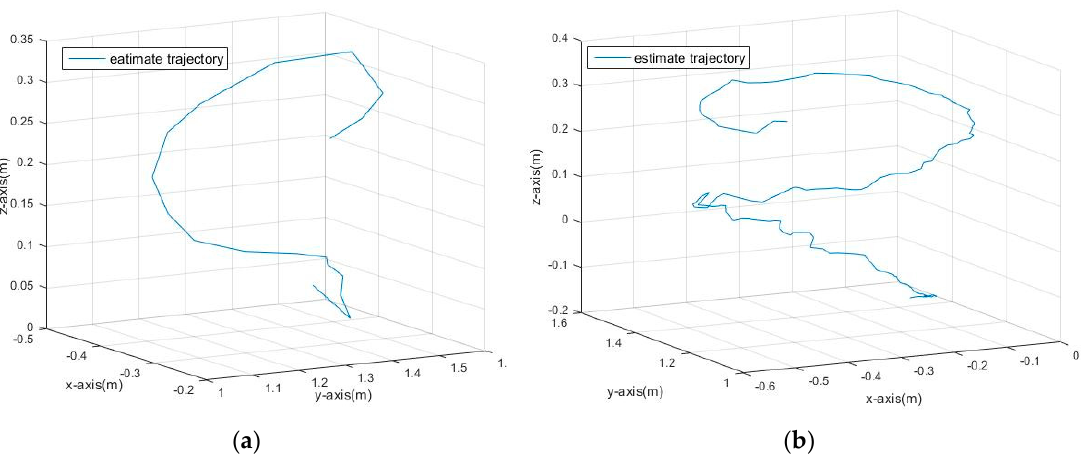
Figure 18. The tracking results in 3D space: ( a ) Results with KF; ( b ) Results with adaptive PF.